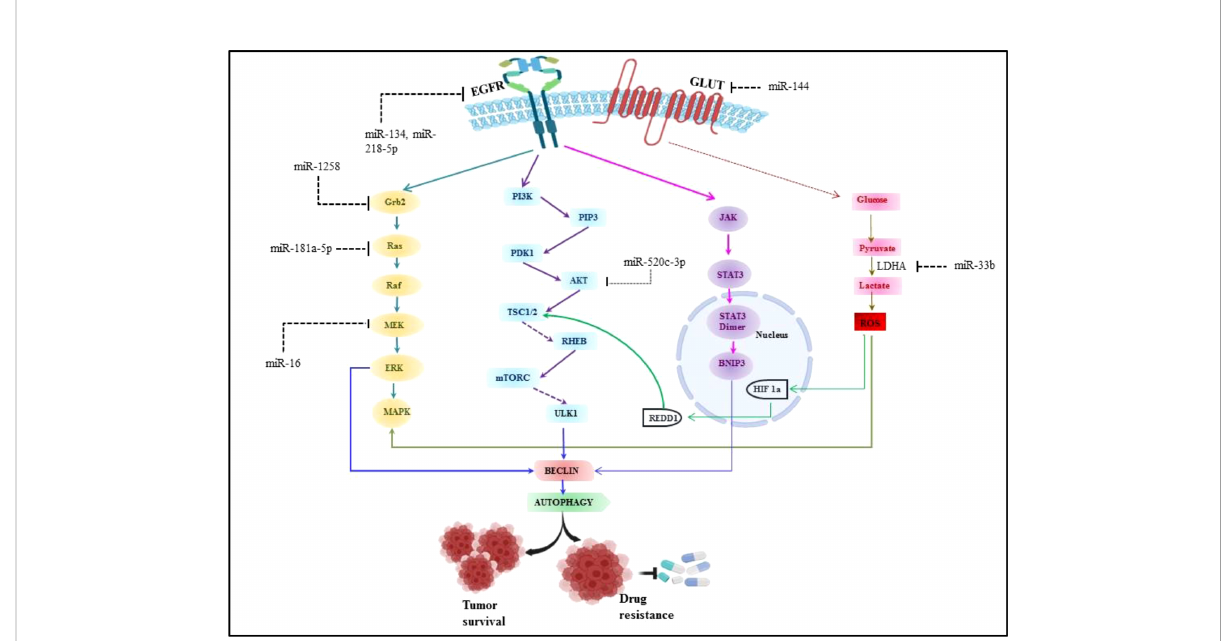
FIGURE 5 Perturbed EGFR signaling leading towards autophagy and key regulatory miRNA in EGFR signalling in